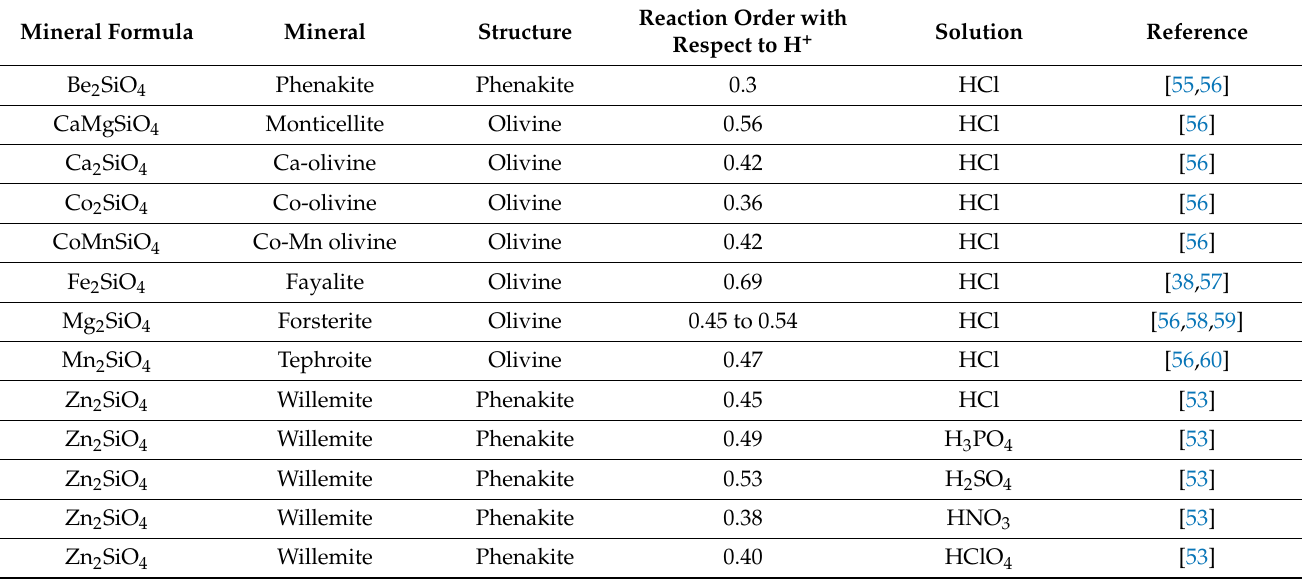
Table 2. Orders of reaction with respect to H + for the dissolution for the orthosilicate minerals. Mineral